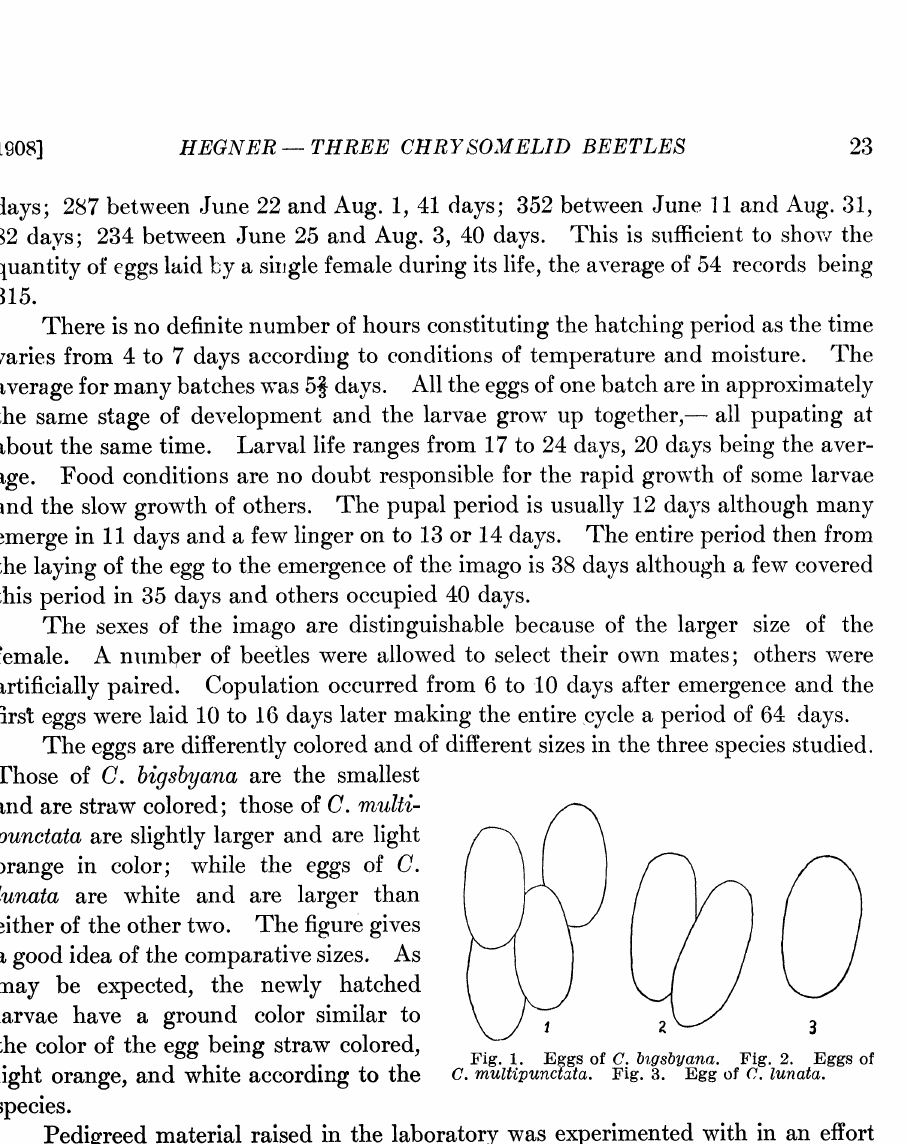
:Fig. 1. Eggs of C. bzgsbyana. Fig. 2. Eggs of C. multipunctMa. :Fig. 3. Egg of C.